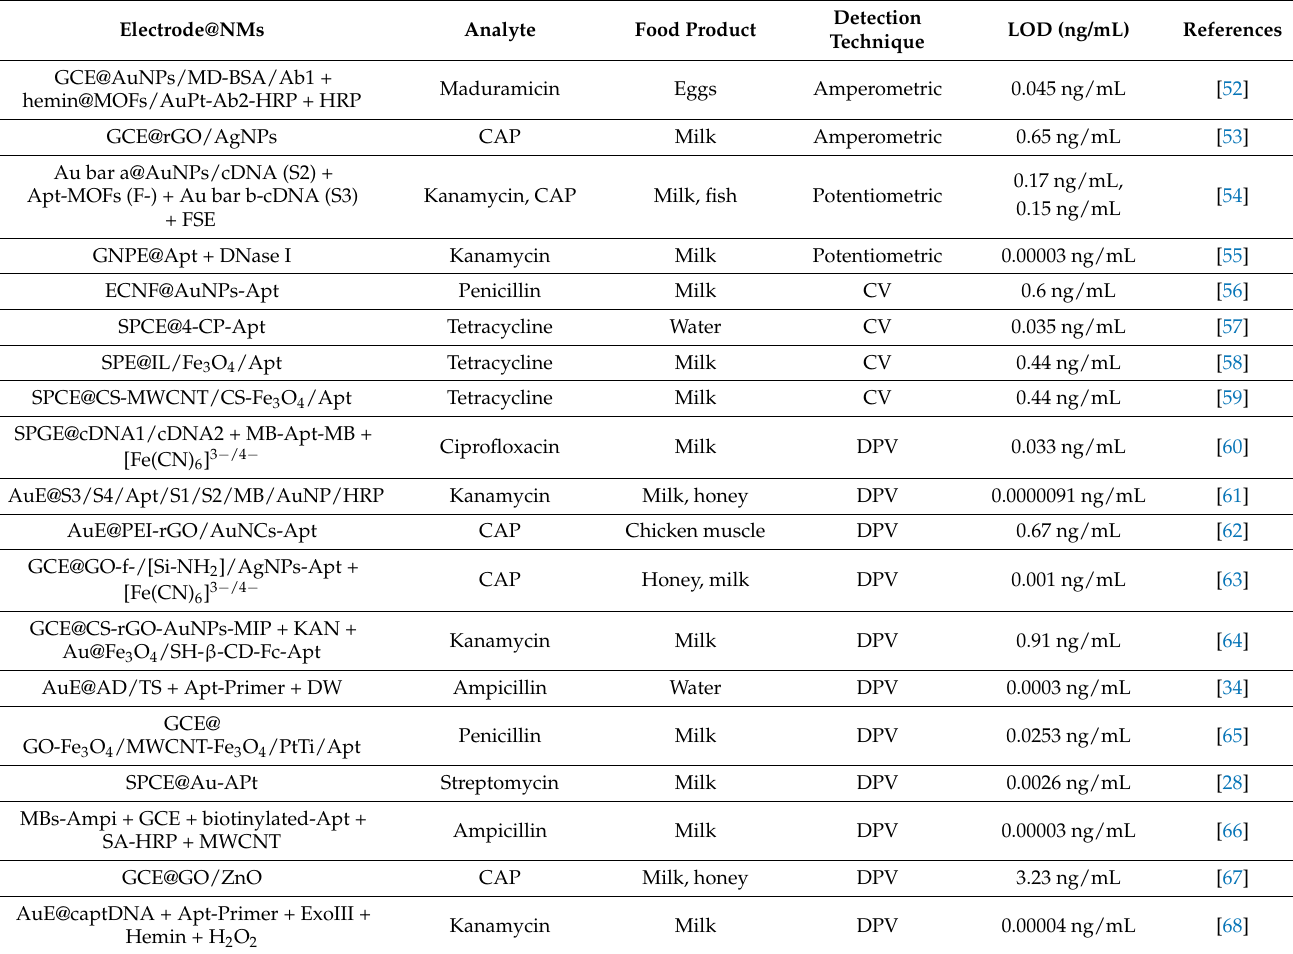
Table 2. Electrochemical aptasensors for the detection of antimicrobial residues in food